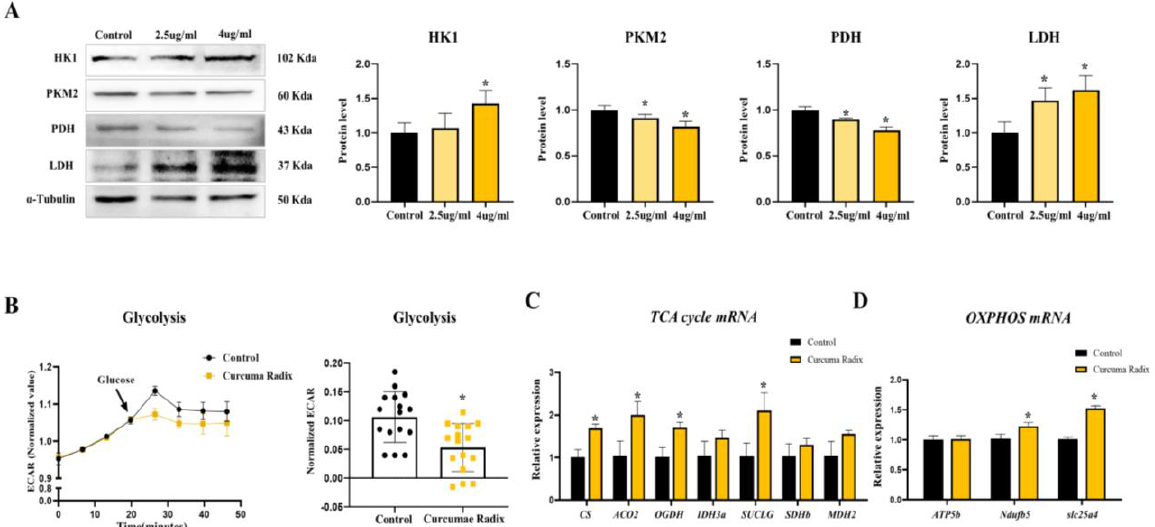
Figure 4. Curcumae radix decreases glycolysis and increases the TCA cycle. ( A ) Western blot analysis and quantification of glycolysis related genes were evaluated in DBT cells of CRE-treated mice. Alpha-Tubulin was used as an internal control. CRE group treated CRE 2.5 μg /mL,4 μg /mL. ( B ) Glycolysis rate measured using flux analyzer in DBT cells. Values were normalized to baseline. Glycolysis was evaluated by measurements from the extracellular acidification rate (ECAR). As indicated by the arrow, glucose was injected at a concentration of 25 mM in the cell. The CRE group was treated with CRE 4 μg /mL. ( C ) TCA cycle genes mRNA levels were measured by quantitative RT-PCR in DBT cells of CRE-treated mice. The CRE group was treated with CRE 4 μg /mL. RPLP0 was used as an internal control. ( D ) OXPHOS genes mRNA levels were measured by quantitative RT-PCR in DBT cells of CRE-treated mice. The CRE group was treated with CRE 4 μg /mL. RPLP0 was used as an internal control. The values stand for means ± S.D. * p < 0.05 was compared to the groups indicated. All experiments were repeated at least 3 times.